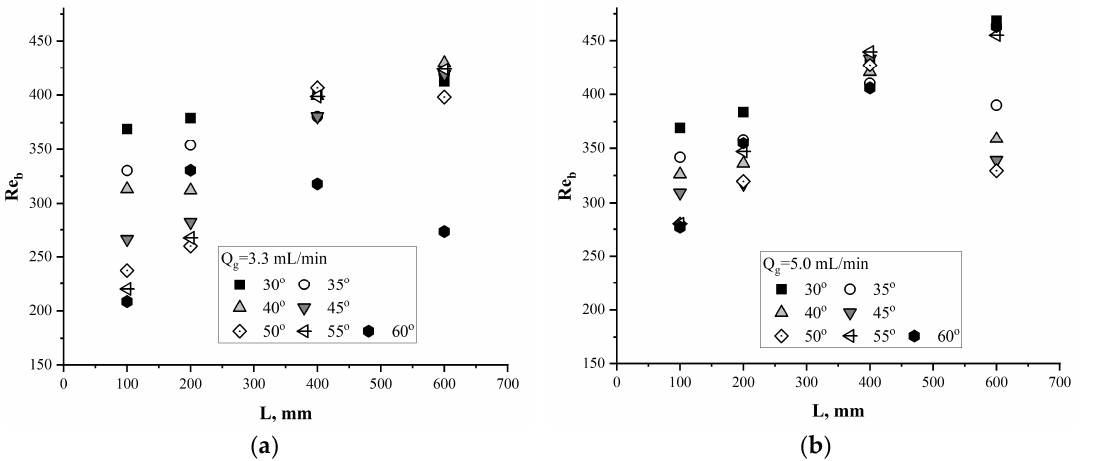
Figure 9. The dependence of the Reynolds number Re b on the distance between the gas input point and the camera shooting point. Angle of inclination of the pipe θ = 30°–60°, gas flow rate ( a ) Q g = 3.3 mL/min; ( b ) Q g = 5.0 mL/min. ( a ) Q g = 3.3 mL/min; ( b ) Q g = 5.0